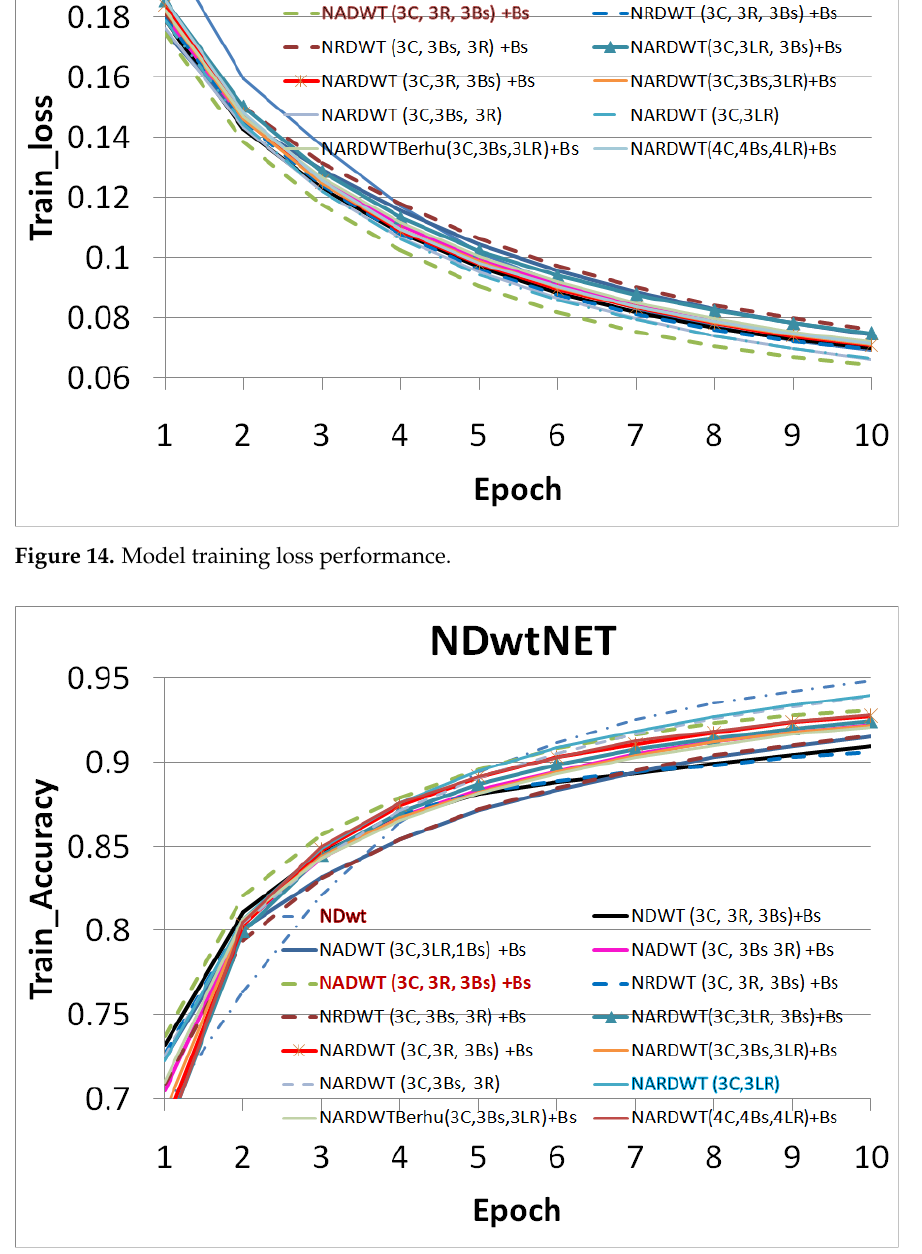
Figure 15. Model training accuracy